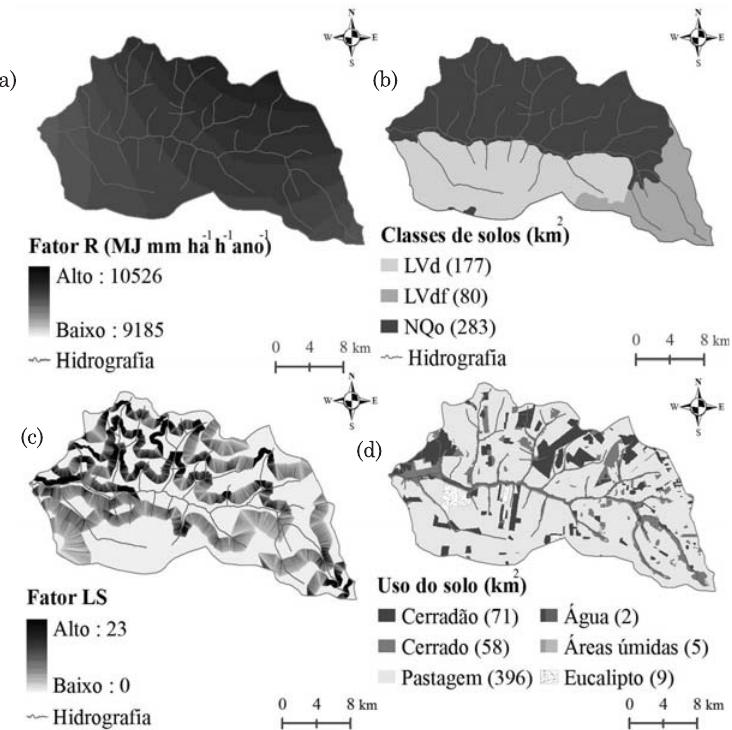
Figura 2. Dados obtidos para integração no modelo USLE: erosividade (fator R) (a); erodibilidade (fator K) (b); fator topográfico (LS) (c); e uso e manejo do solo (fator C)